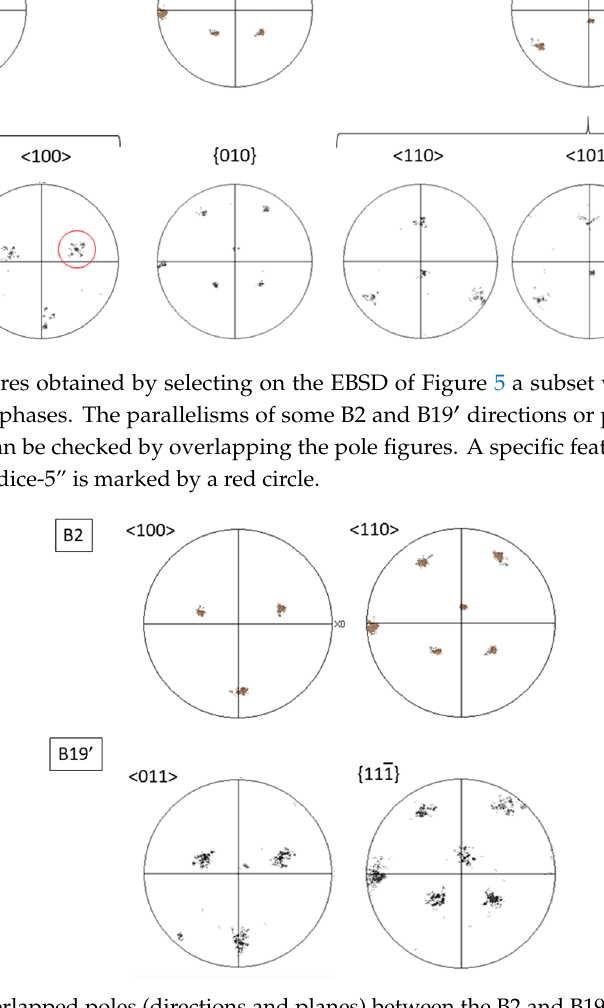
Figure 8. Other overlapped poles (directions and planes) between the B2 and B19 ′ phases obtained on a subset of the EBSD map of Figure 5.